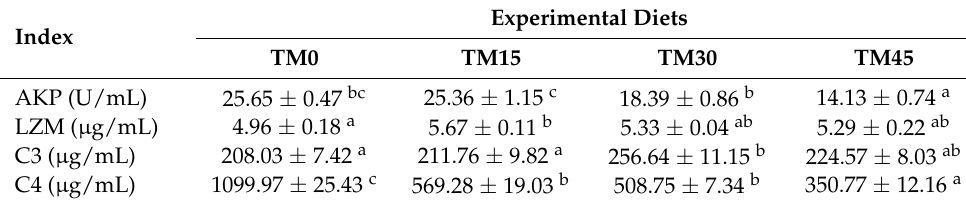
Table 5. Serum immunity indexes of large yellow croakers fed diets with different levels of